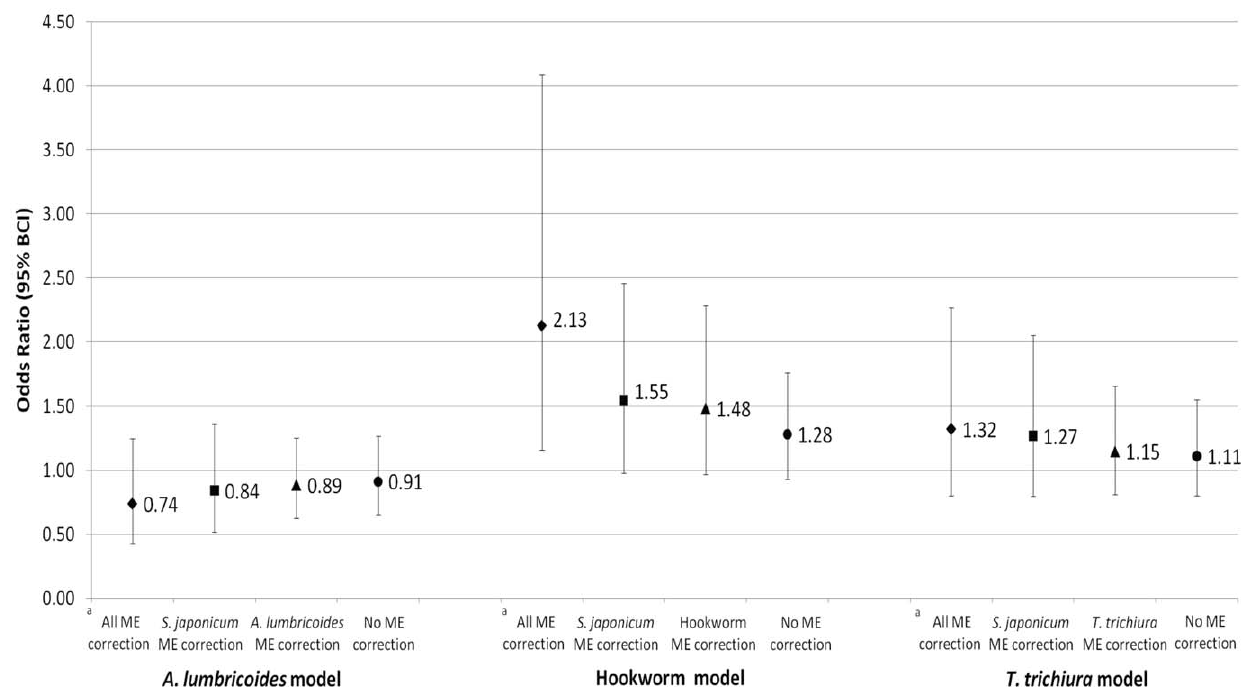
Figure 1. Odds ratio estimates for the exposure variable with and without correction for misclassification error. Exposure variable is respective soil-transmitted helminth infection; All odds ratio estimates are adjusted for age, sex, and occupation; BCI: Bayesian credible intervals; ME: misclassification error; a Correction of misclassification error in exposure (respective STH infection) and outcome ( S. japonicum infection) assessment.